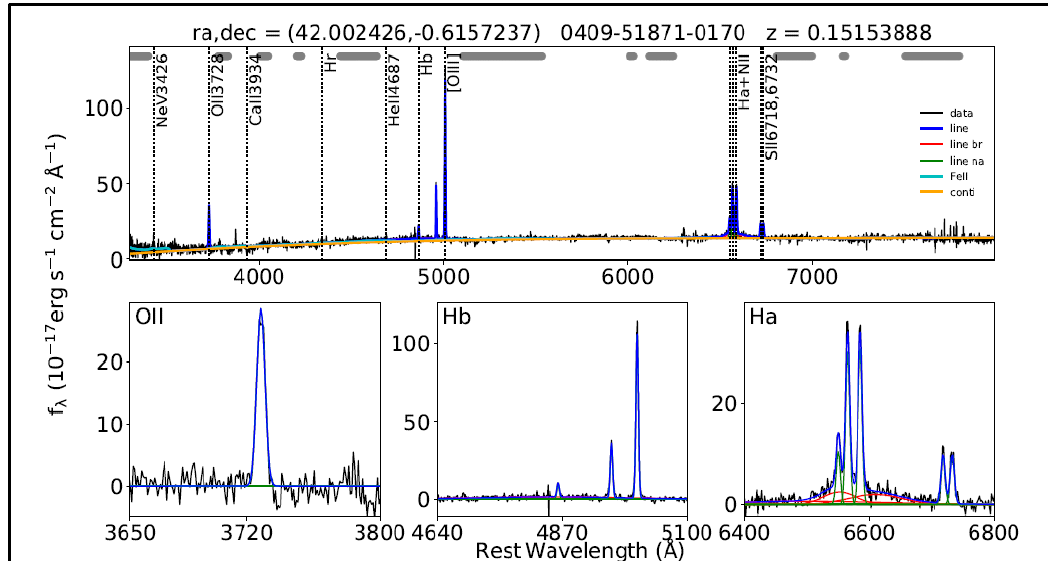
Fig.2: Spectral modeling for seyfert galaxies type2. The observed galaxy is shown in black line. The staller continuum in faint brown line. The fitting component are shown in different colors. Fe in teal II